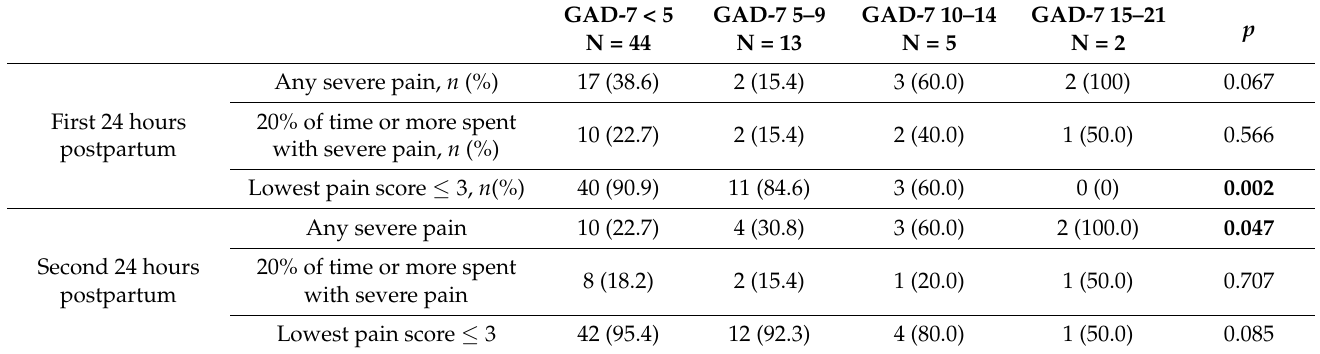
Any severe pain, n (%) pain, n (%) Lowest pain score ≤ 3, n (%)